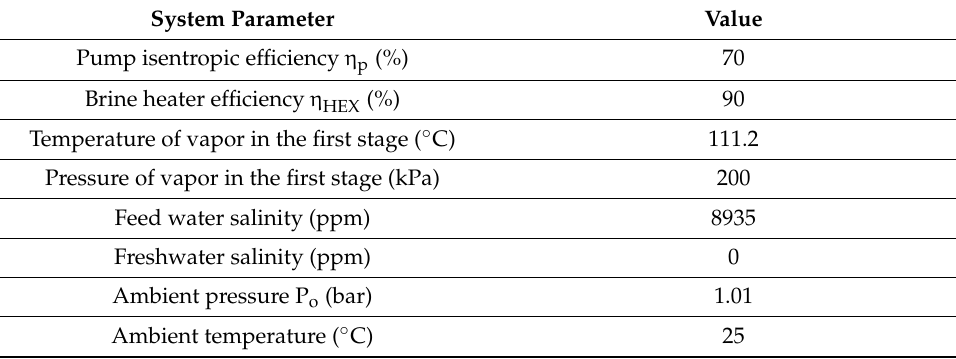
Table 2. Modeling parameters [26,27]. System Parameter Value Pump isentropic efficiency η p (%) 70 Brine heater efficiency η HEX (%) 90 Temperature of vapor in the first stage ( ◦ C) 111.2 Pressure of vapor in the first stage (kPa) 200 Feed water salinity (ppm) 8935 Freshwater salinity